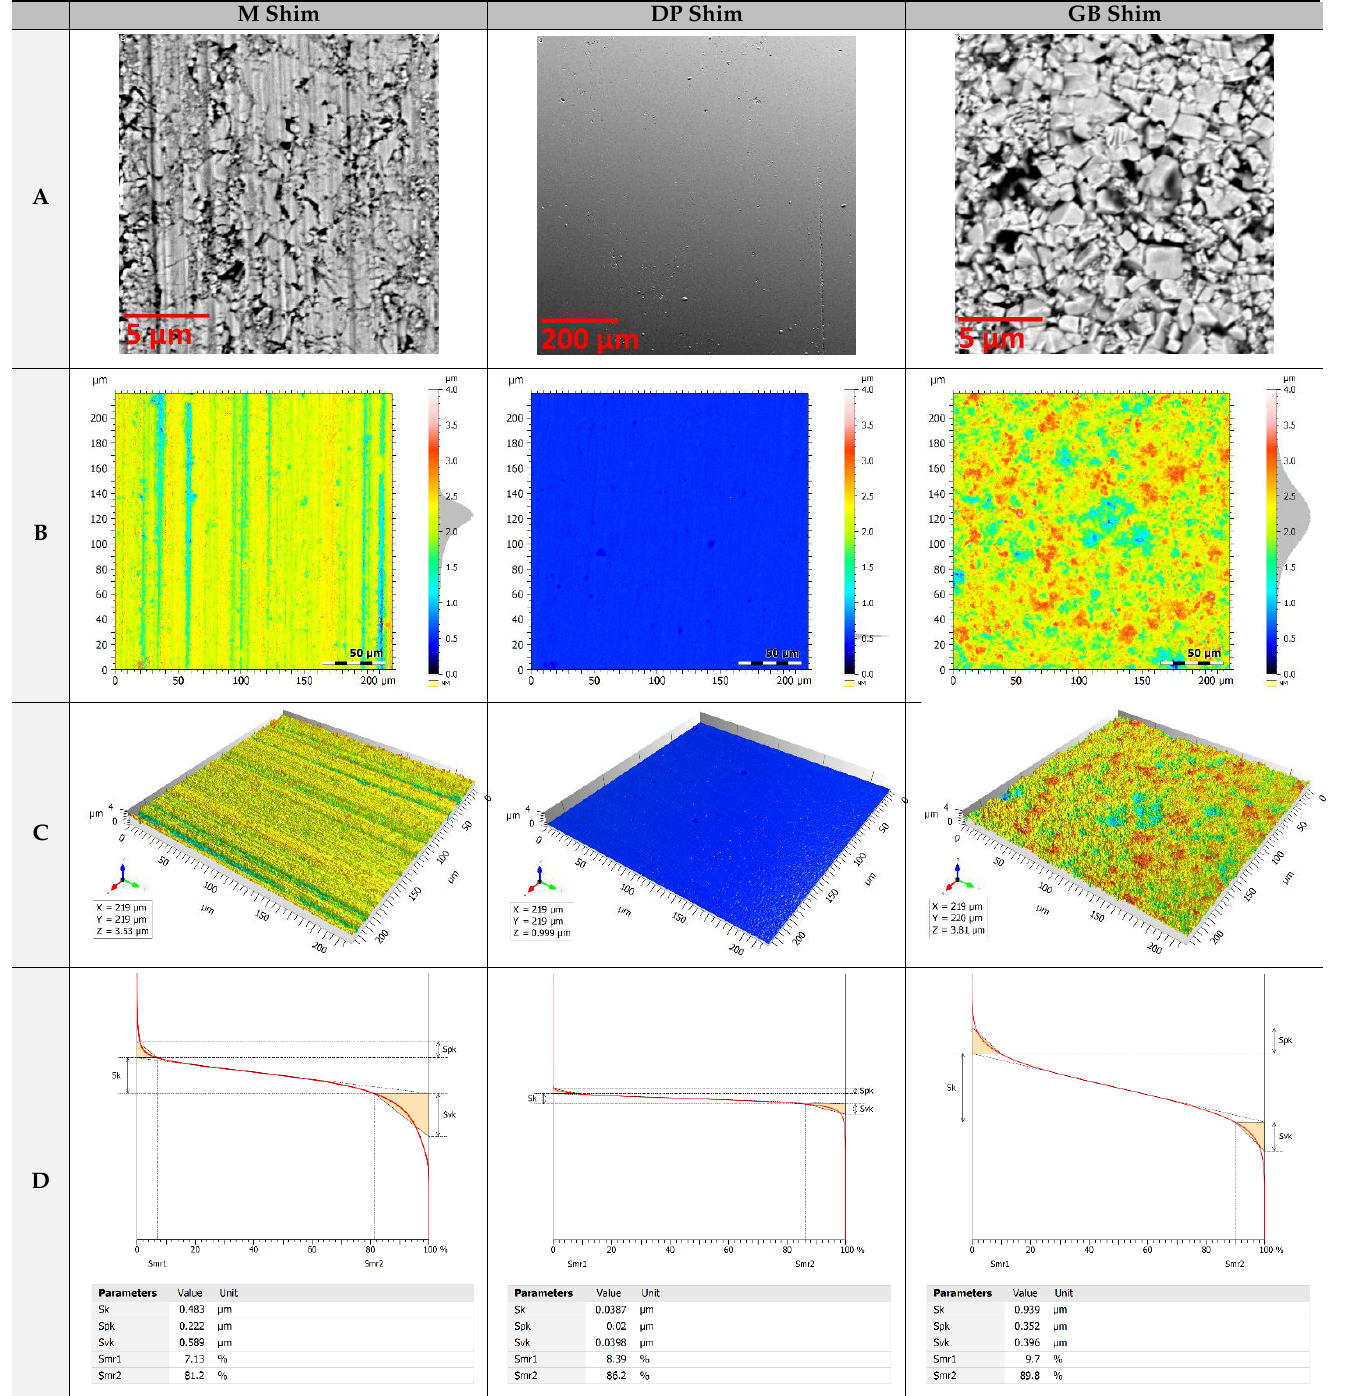
Table 4. Shim surface texture analysis before the coating process: ( A ) SEM images; roughness (S-L surface) areal surface texture, ( B ) 2D pseudo-colour view, ( C ) 3D view, and ( D ) Sk group of functional surface parameters and graphical representation. M Shim DP Shim